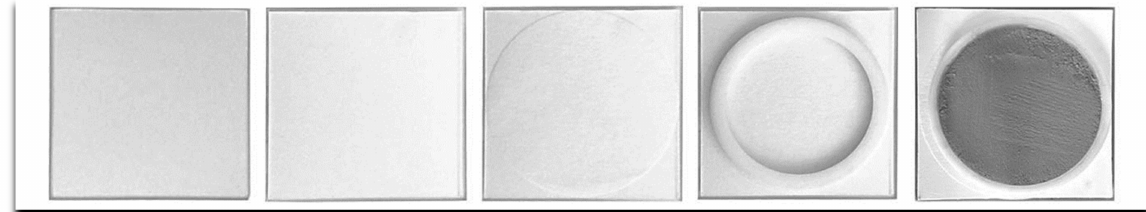
Figure 5. From the right: glass plate (GP), GP and filter paper plate (GFP), GFP and non-woven tissue (GFPT), GFPT and plastic ring (GFPTR), GFPTR with the fresh mortar placed.